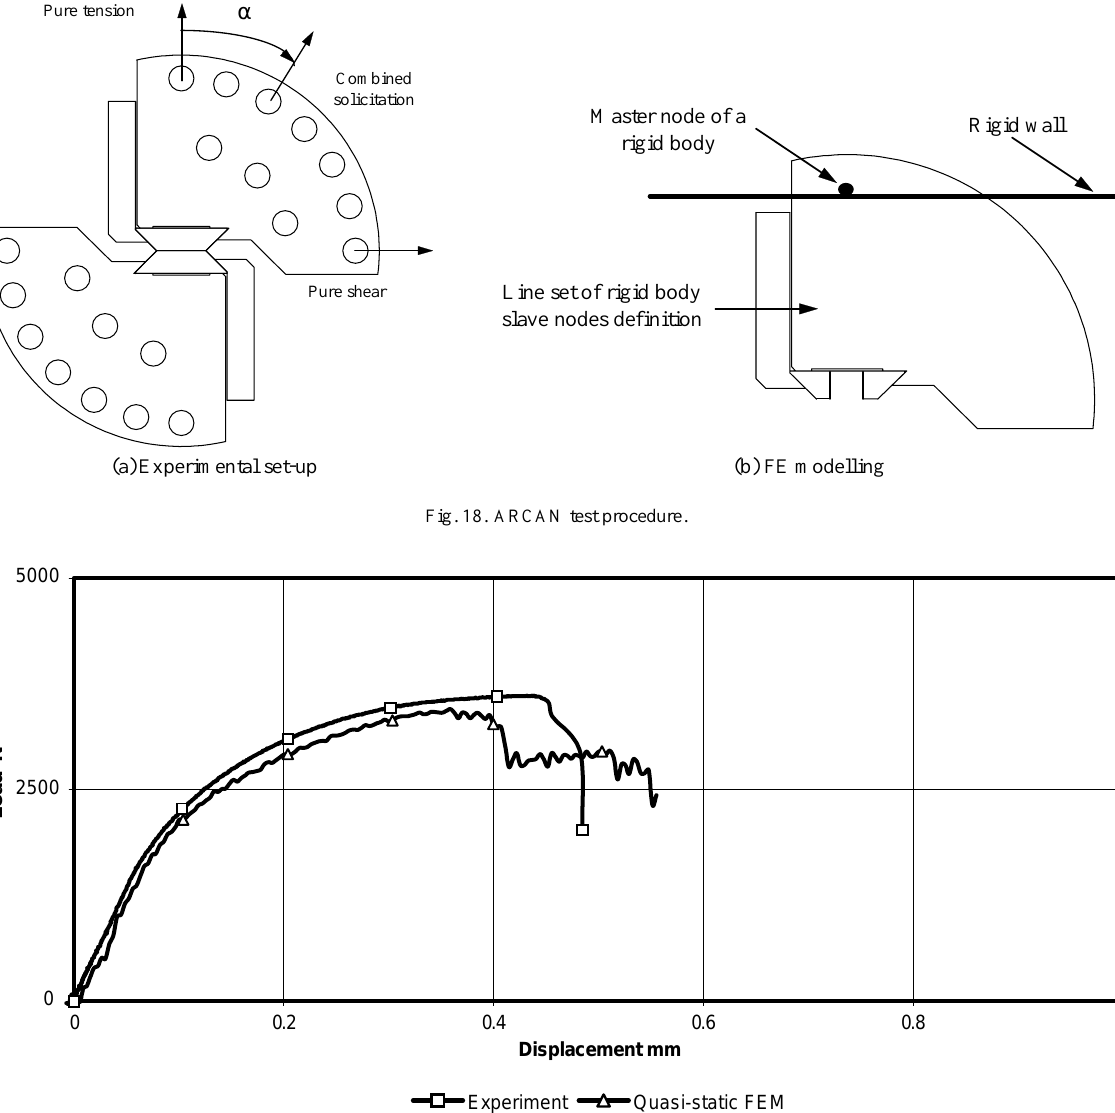
Fig. 18. ARCAN test procedure.